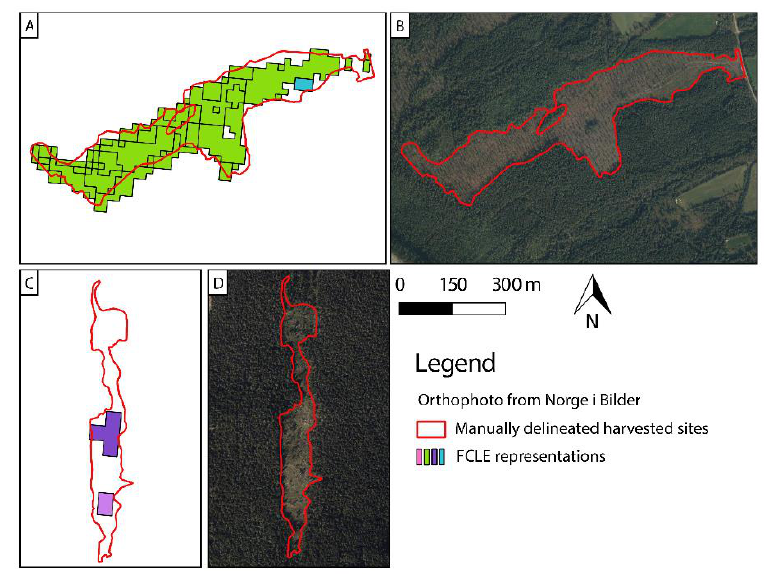
Figure 8. Examples of a correctly represented harvesting site in FCLE ( A , B ), and a large underestimation ( C , D ).